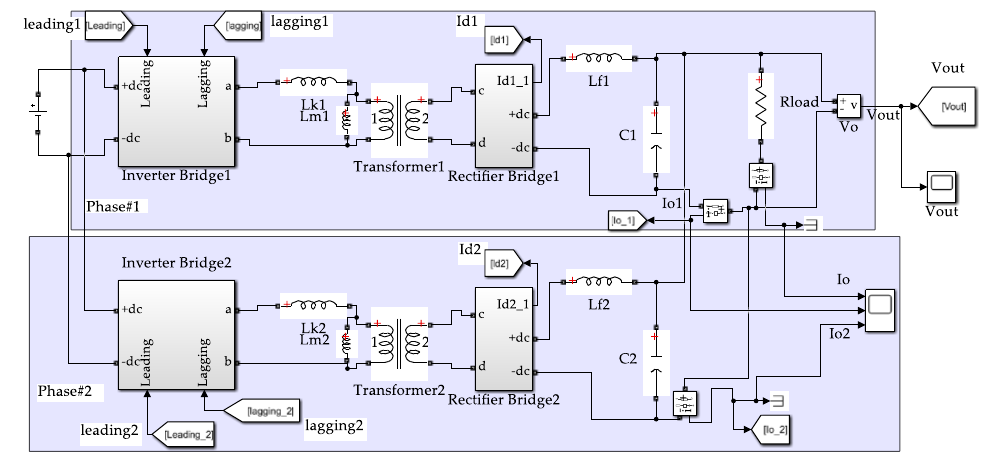
Figure 12. Circuit part of simulation model.